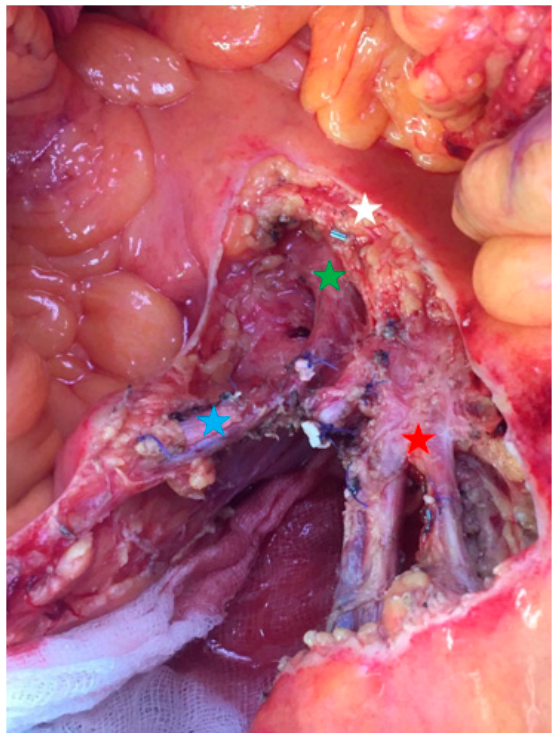
Figure 5. Operative view focusing on the proximal nodal resection (group 3). Red star: proximal jejunal arteries and veins; blue star: superior right colic artery and vein; green star: superior mesenteric vein; white star: pancreas.